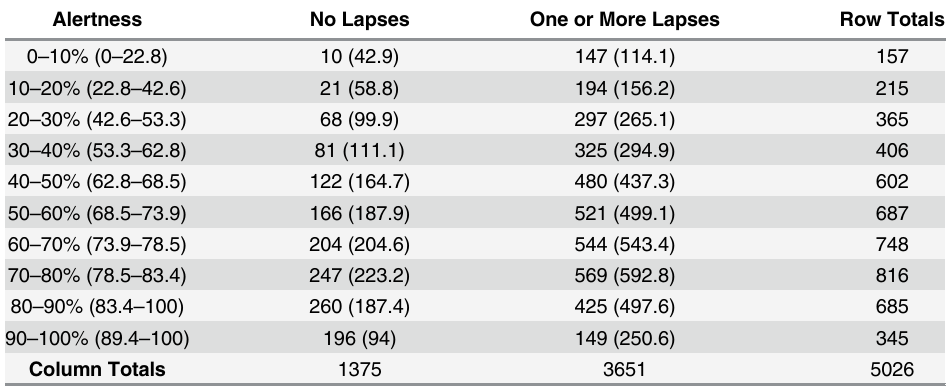
Table 1. Contingency Table of Alertness vs. Absence or Presence of PVT